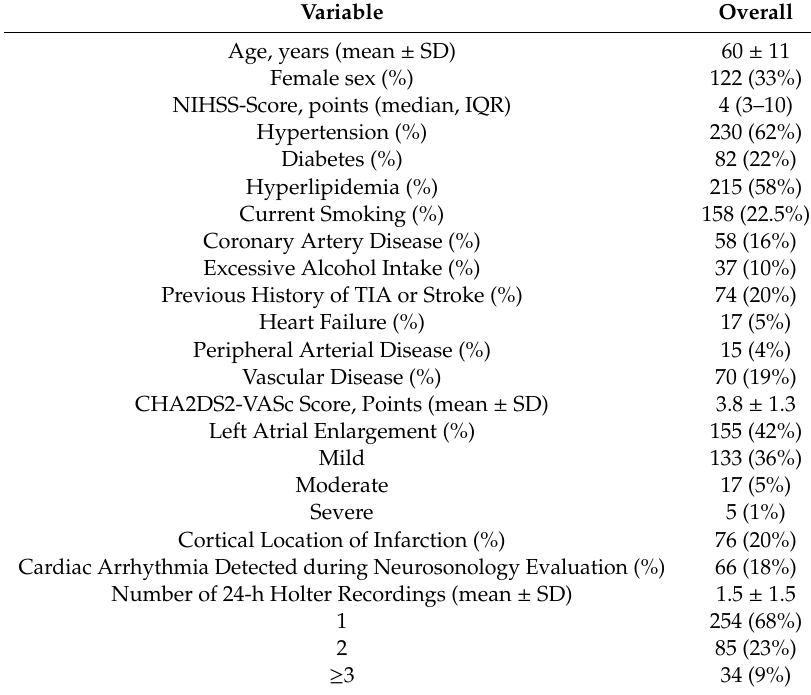
Table 1. Baseline characteristics of the study population ( n =